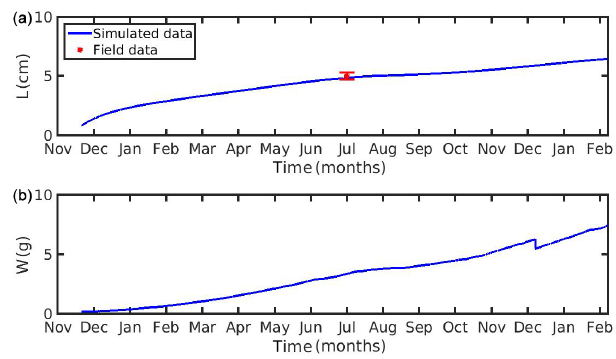
Figure 4. (a) Simulated mussel shell length ( L ) and (b) fresh tis- sue mass ( W ) against North Sea data (red star: mean ± SD), using chlorophyll a , X = [ CHL a ] , in the mussel diet.